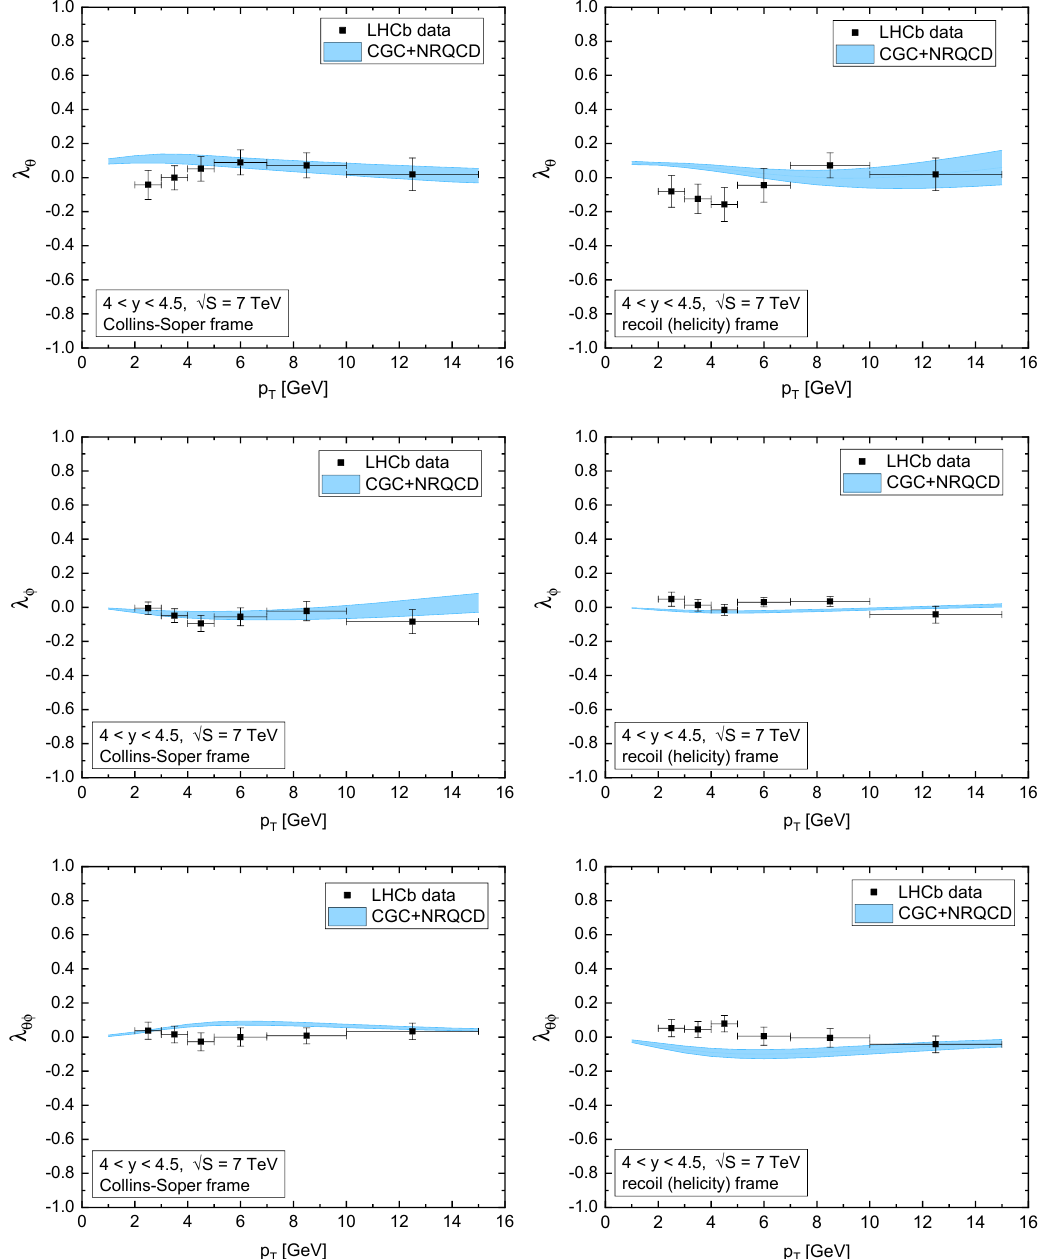
Figure 5 . The angular coe(cid:14)cients (cid:21) (cid:18) ((cid:12)rst row), (cid:21) (cid:30) (second row) and (cid:21) (cid:18)(cid:30) (third row) in the Collins-Soper frame (left column) and recoil frame (right column) as functions of J= transverse momentum p T . Data are from the LHCb experiment at 7 TeV [16], for the highest rapidity window 4 < y < 4 : 5.